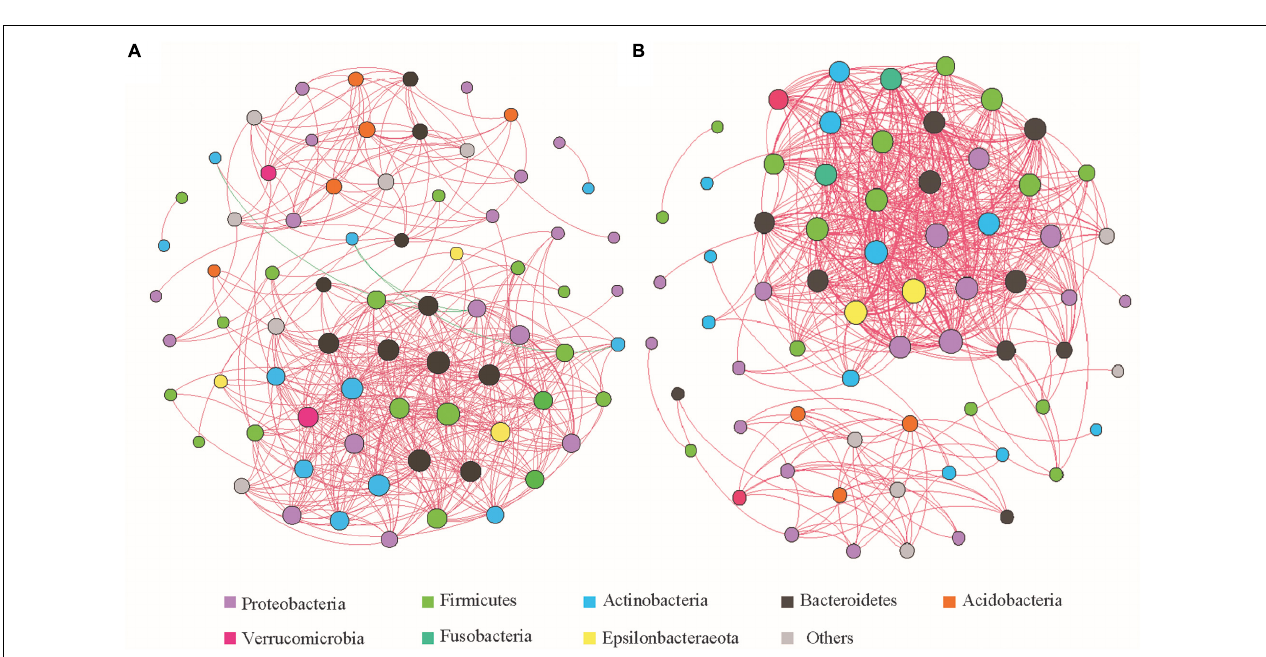
FIGURE 4 | Comparison of differences in the main compositions of gut microbiota of the common kestrels before and after captivity. Differences in relative abundance among the top five core phyla (A) and the top 10 core genera (B) were analyzed. ∗ and ∗∗∗ indicate significant differences at P < 0.05 and P < 0.001, respectively.